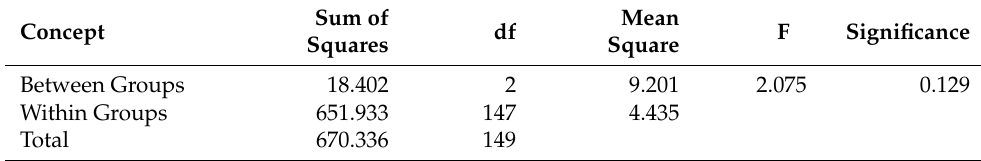
Table 3. ANOVA test results for the academic year 2018–2019.